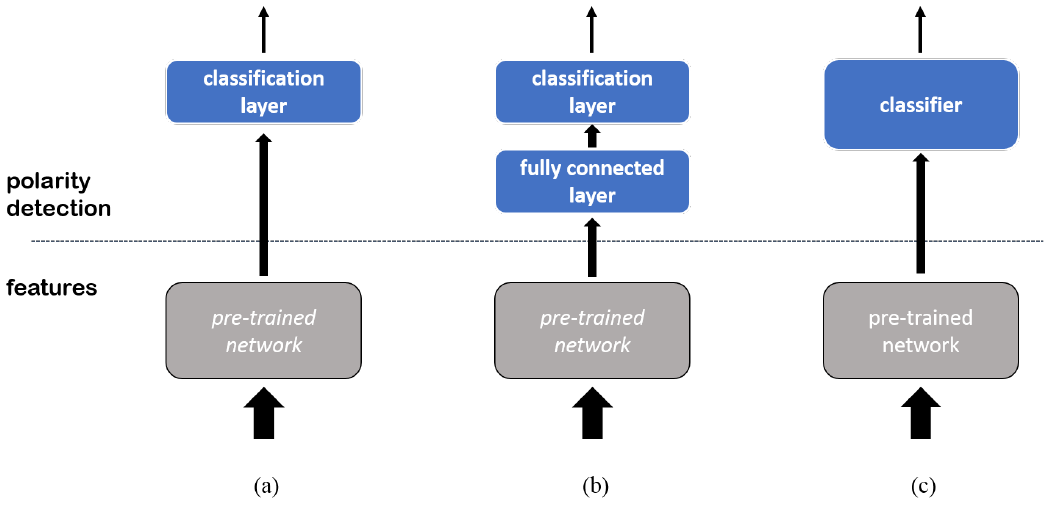
Figure 5. Three different configurations of the polarity predictor: ( a ) layer replacement; ( b ) layer addition; ( c ) classifier. Blocks with bold refers to modules that are retrained from scratch; blocks with italics refer to modules that are subject to